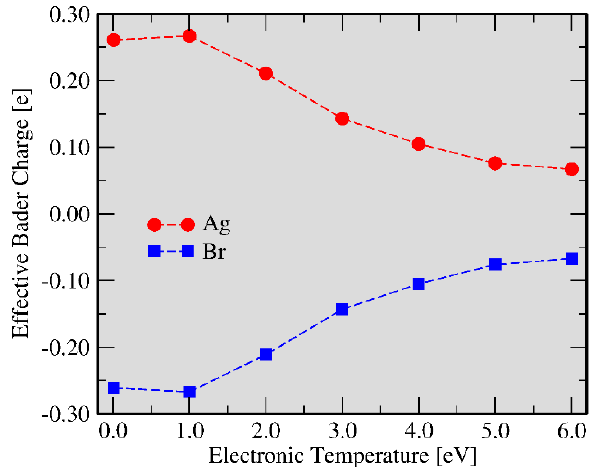
Figure 8. Effective Bader charge average calculation. The Ag (electropositive) atoms are represented in red, and Br (electronegative) atoms are represented in blue.